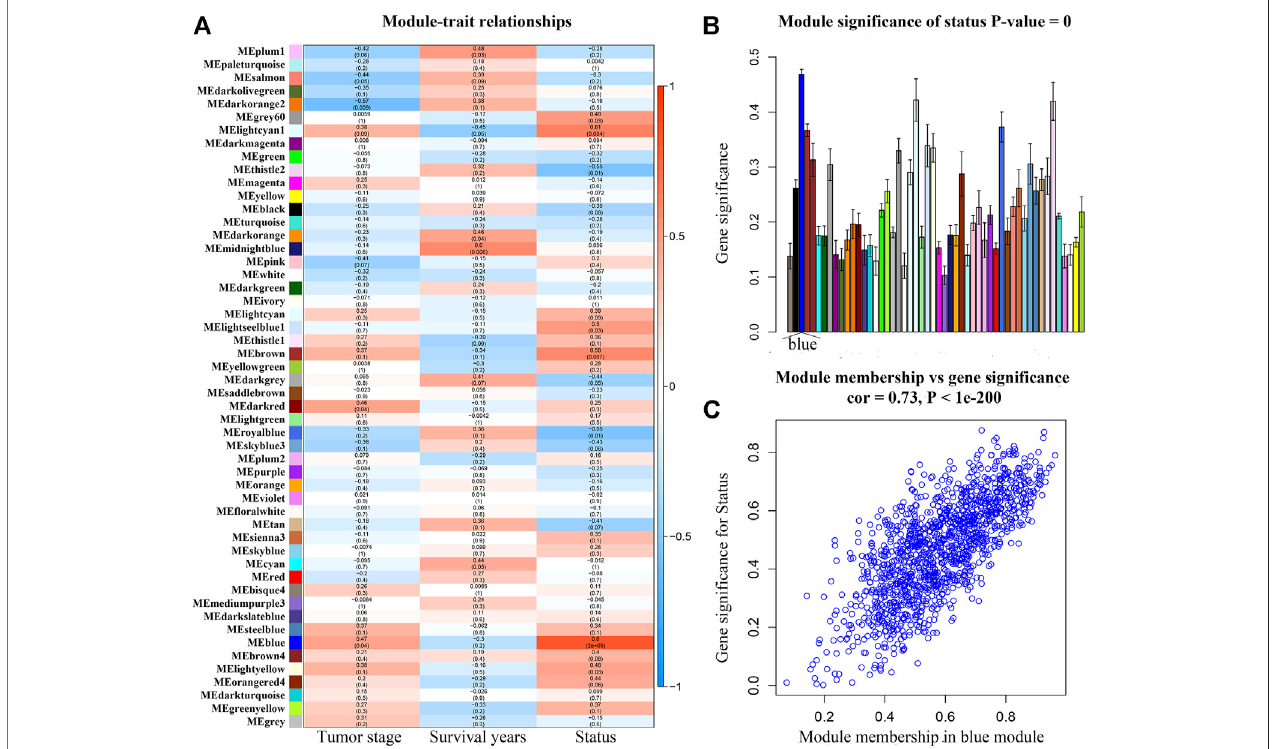
FIGURE 2 | (A) Heatmap of the correlation between module eigengenes (MEs) and different clinical information of ACC [tumor stage, survival years (survival time), and survival status]. (B) Distribution of average gene signi fi cances and errors in the modules associated with the survival status of ACC. (C) Scatter plot of module eigengenes related to survival status in the blue